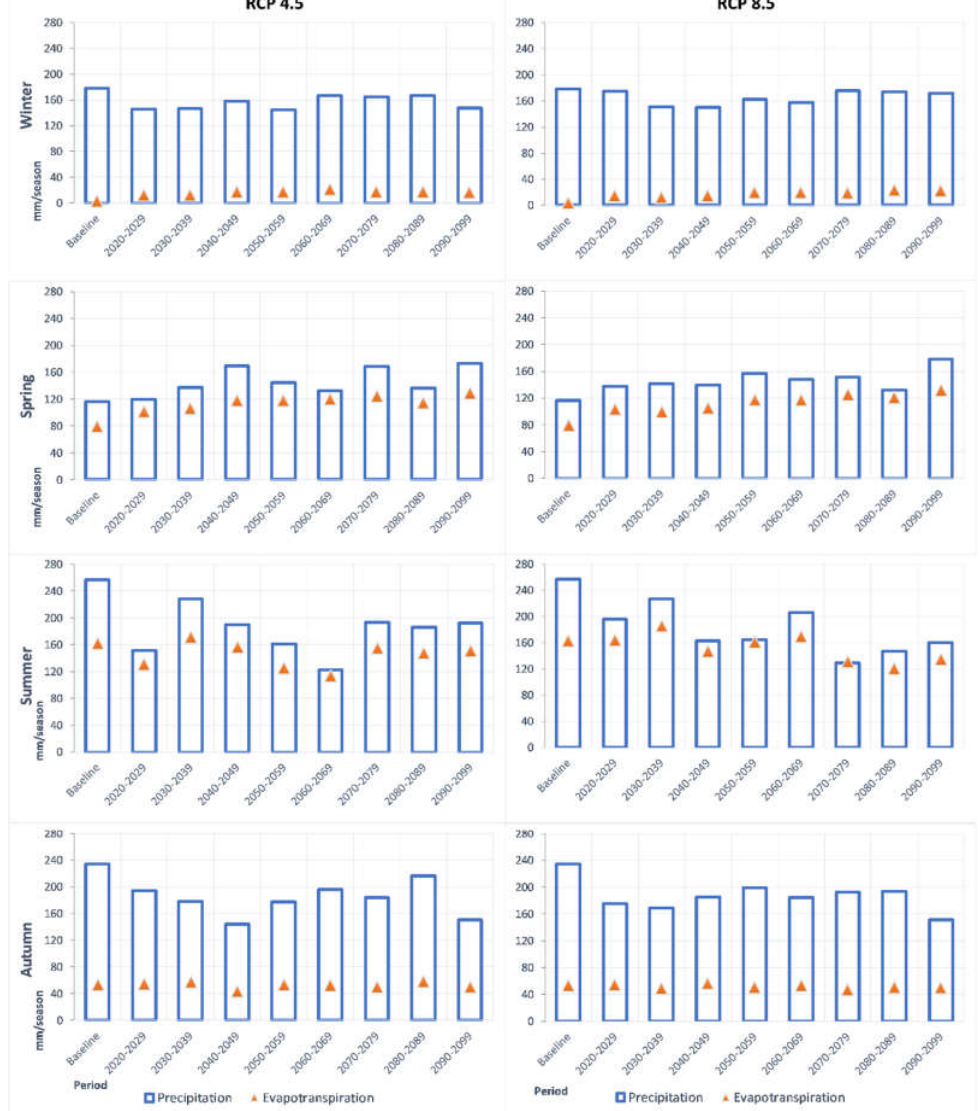
Figure 7. Predicted changes in average total seasonal precipitation and evapotranspiration for each decade of the